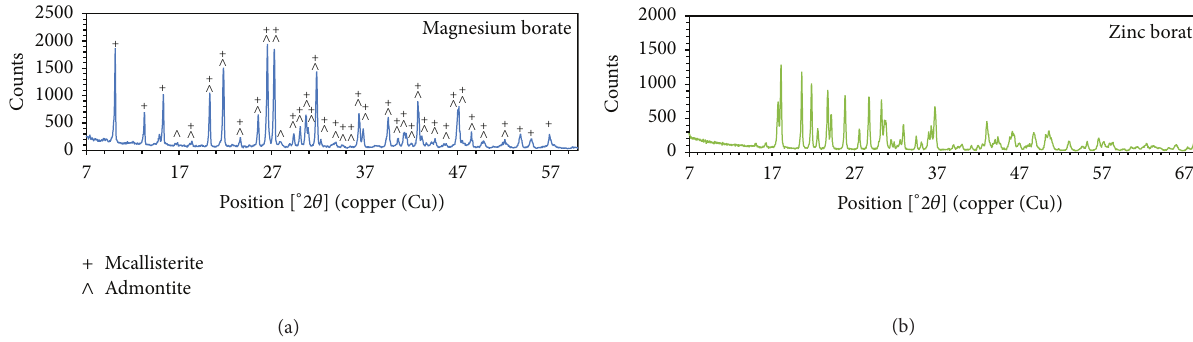
Figure 3: XRD patterns of the optimum phases of the magnesium and zinc